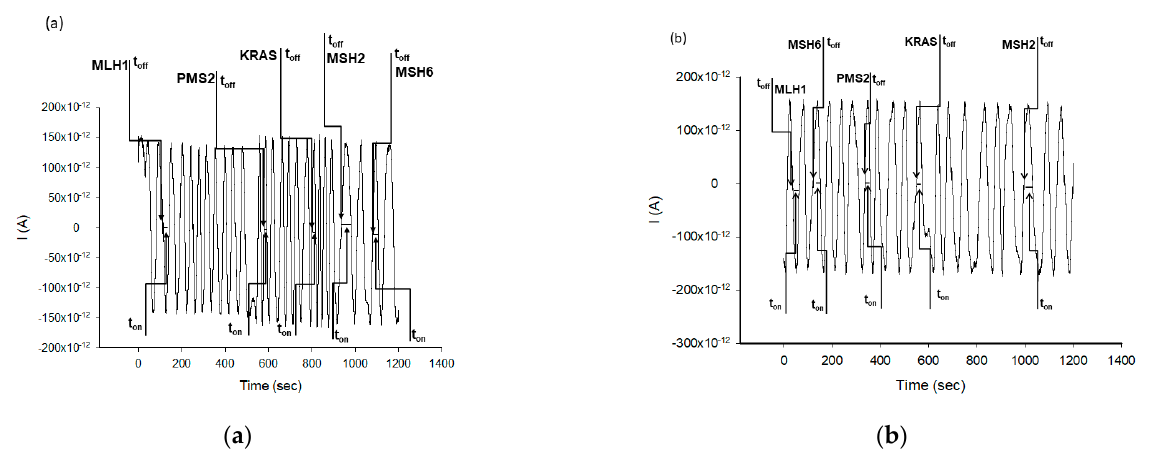
Figure 1. Examples of diagrams obtained for the screening tests of whole blood using the stochastic sensors based on: ( a ) MD/EGR-1 and ( b ) MD/EGR-2.